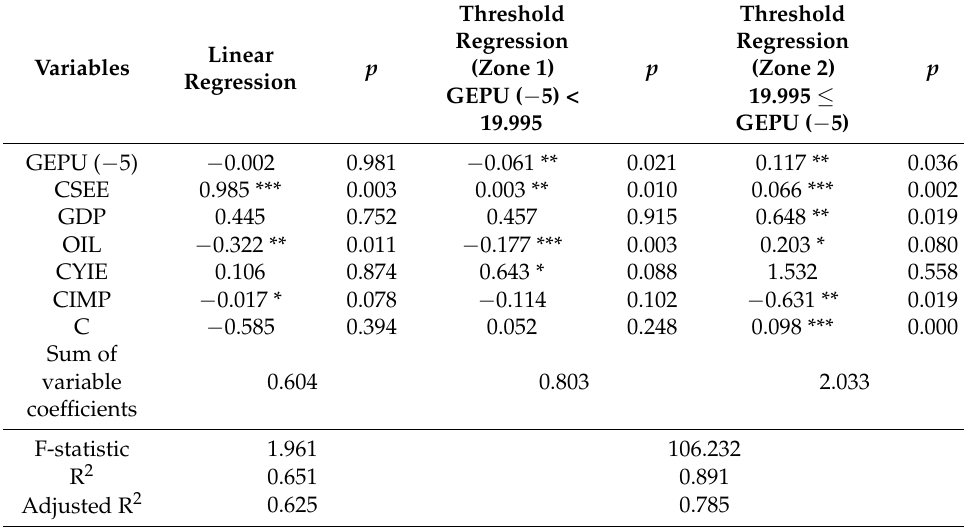
Table 6. Corn price model regression